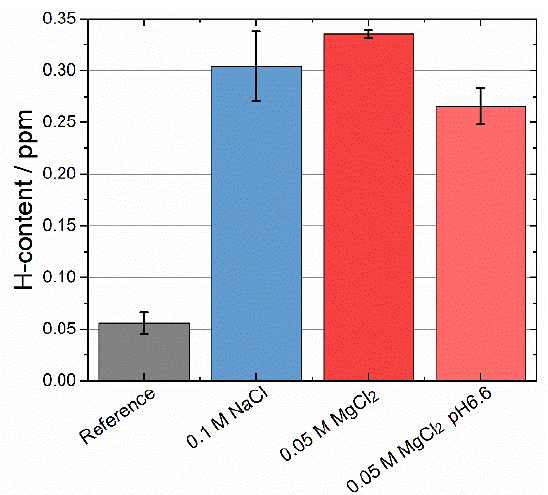
Figure 10. Hydrogen content determined with TDMS after immersion of CP1000 (70 mm × 20 mm) for 48 h in different electrolytes (50 mL) in comparison to non-corroded reference samples.